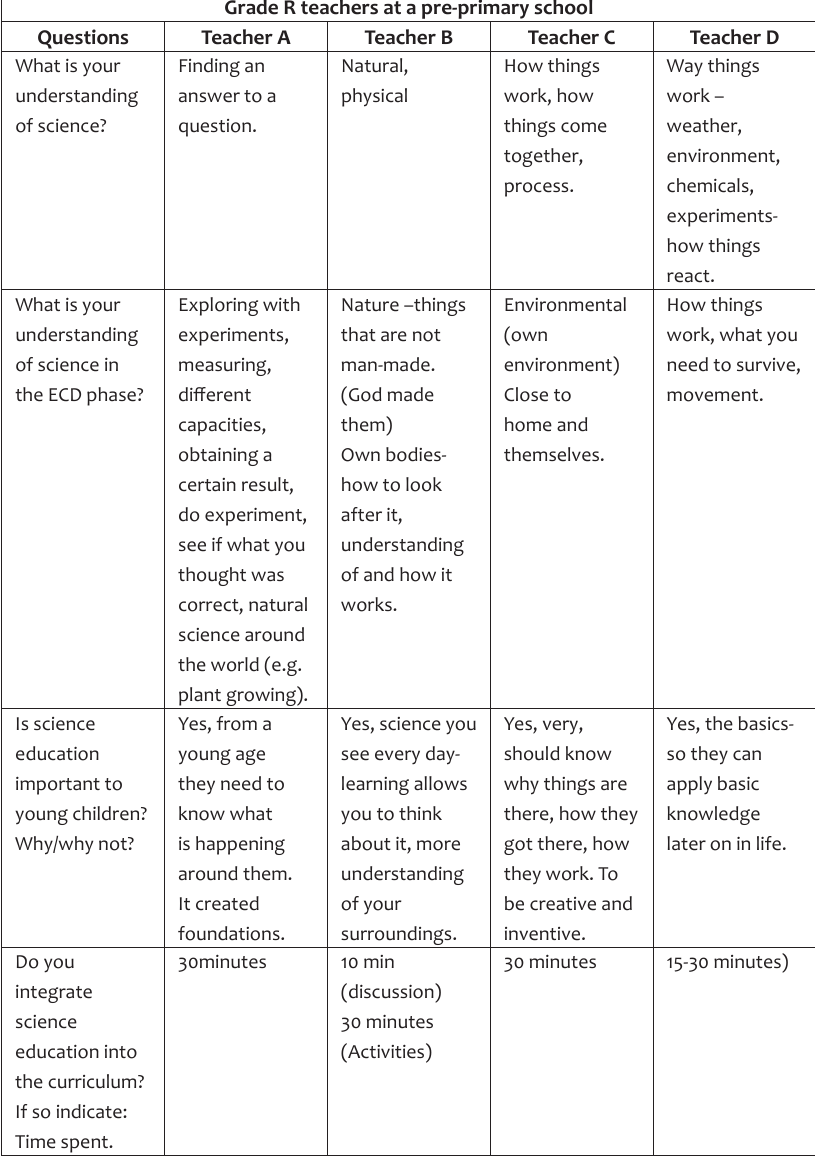
Table 7: Teachers responses (pre-primary